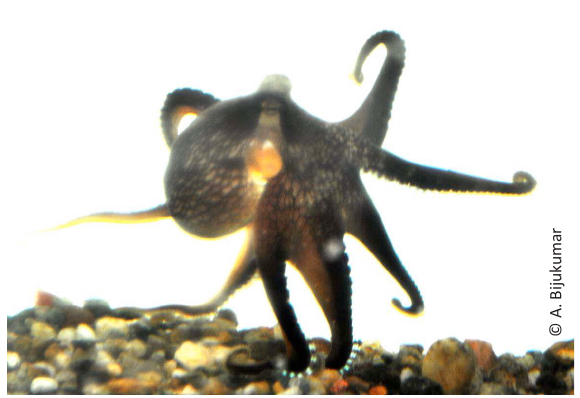
Image 4. A. marginatus (male) displaying flashing of